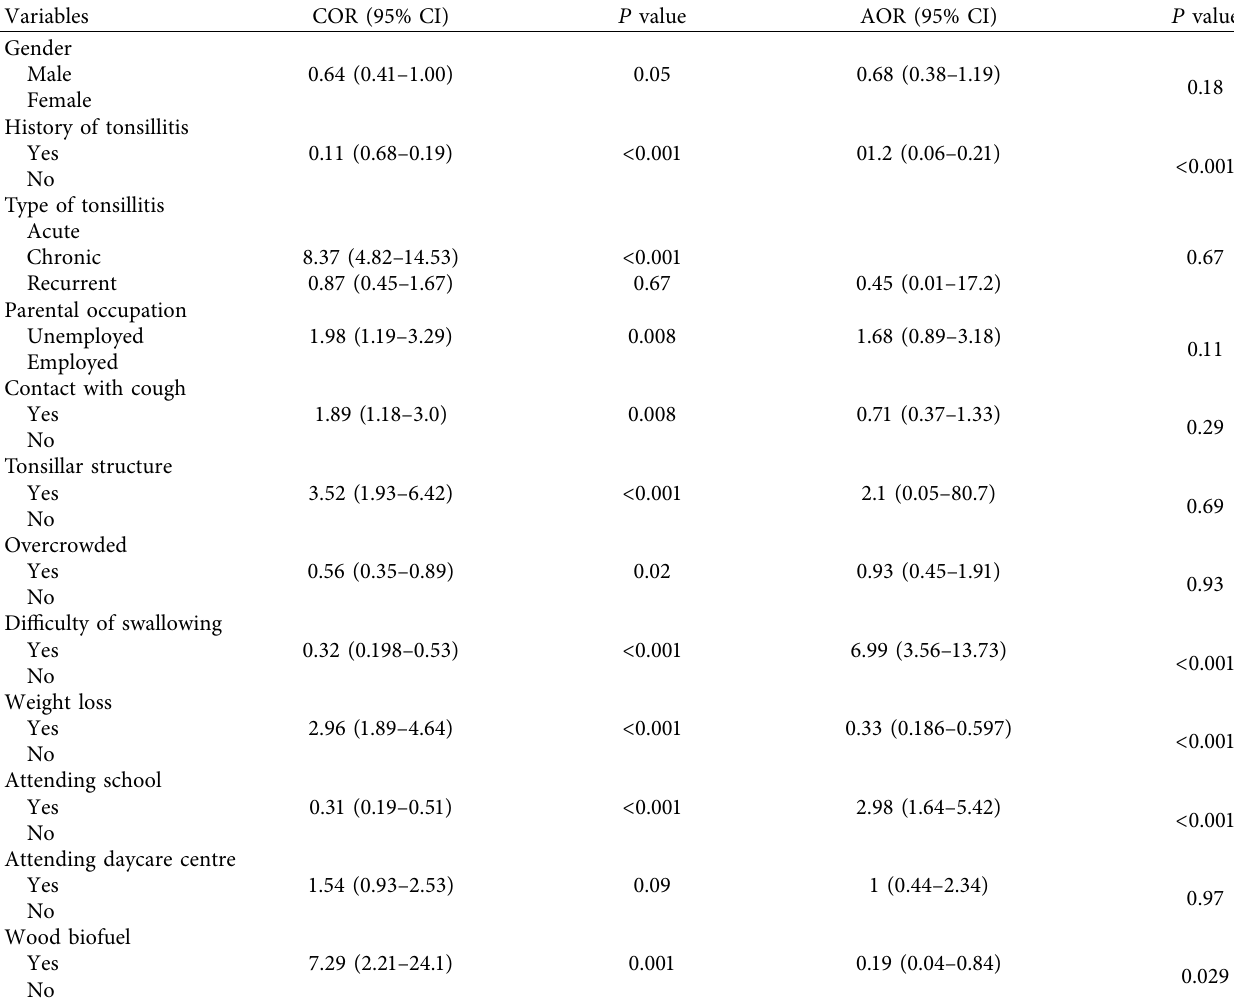
Table 7: Multivariable analysis of factors associated with positive bacterial throat culture among children 2–5 years of age at HGH ( n � 374).